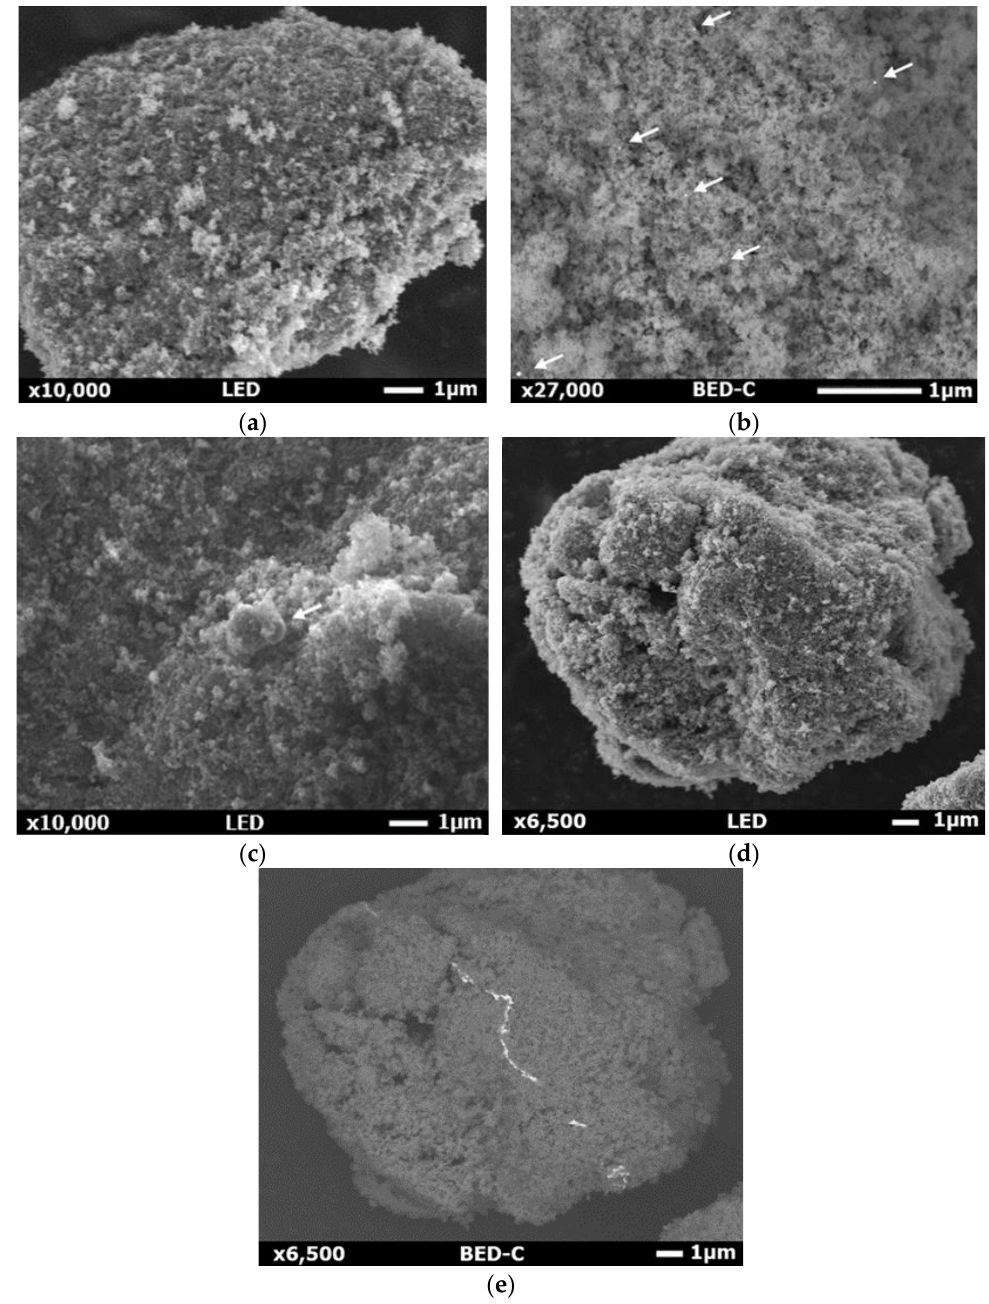
Figure 3. SEM images of ( a ) and ( b ) 0.1 mol% Au/P25, ( c ) 0.1 mol% Pt/P25 and ( d ) and ( e ) 1 wt% (Au 6 Pt 4 )/P25. ( b ) and ( e ) have been taken using backscatter detector (BED-C).